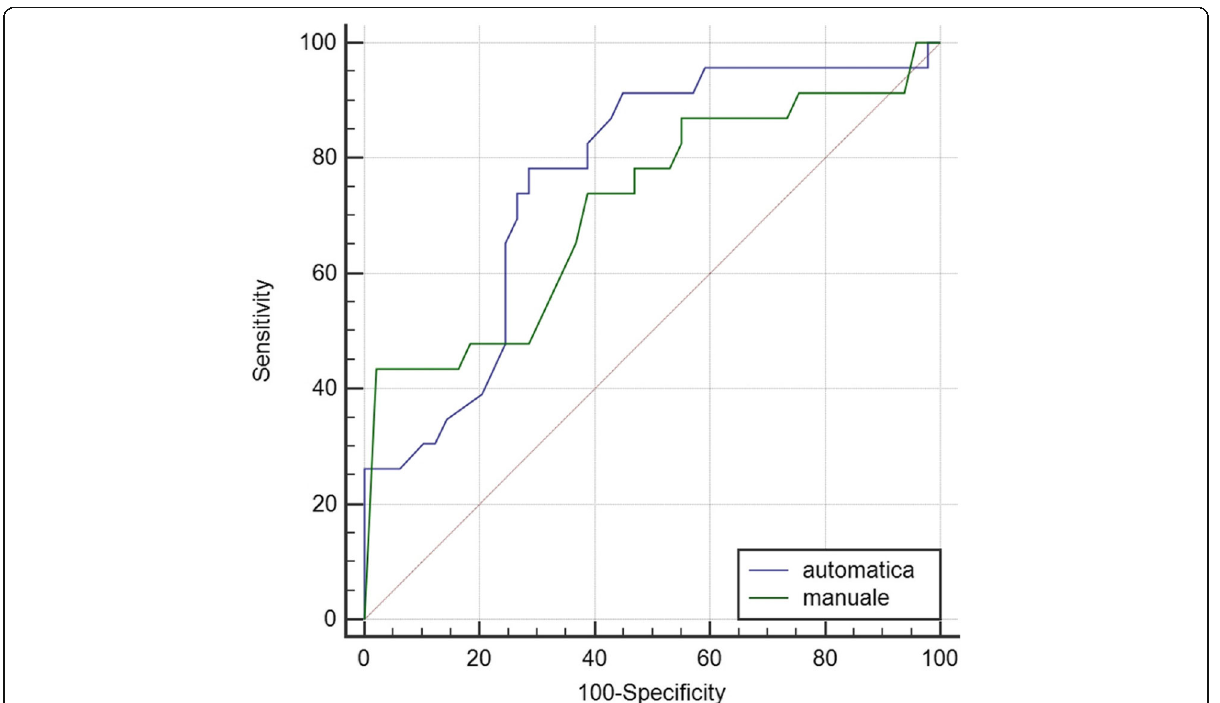
Fig. 5 Comparison between receiver operating characteristic curves for the performance of automatic (blue) and manual (green) tumour-to- nipple-areola complex